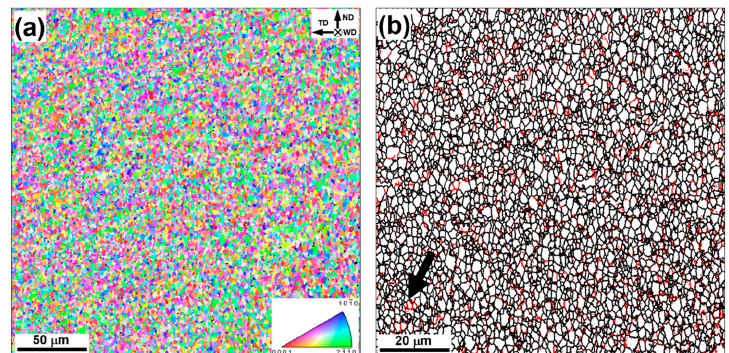
Figure 4. ( a ) Low-resolution EBSD inverse-pole-figure map and ( b ) higher-resolution EBSD grain-boundary map for the α phase taken from the central region of the stir zone. The reference frame for both maps is given in the top right corner of ( a ). In ( b ), low-angle boundaries (LABs) and high-angle boundaries (HABs) are depicted by red and black lines, respectively. Note: The black clusters denote the β phase.